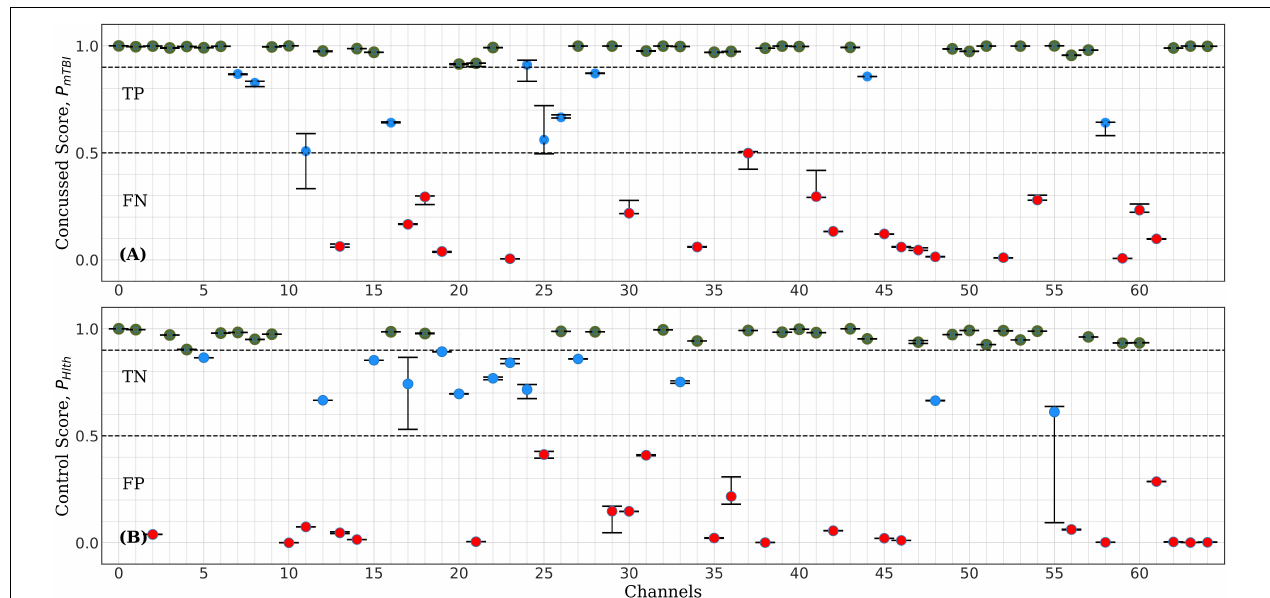
FIGURE 5 | Representative example of ConcNet 2 test output scores (circle markers), P Hlth and P Mtbi , respectively, for one control (bottom) and one concussed (top) participants. The horizontal axis marks the channel number used as input, and the vertical axes correspond to test output scores in the range [0, 1]. The error bars are based on the results of eight data segments per participant, and the circle marker corresponds to the median of these values. Green markers represent channels with medians above 0.9 and 2.5th percentile greater than 0.85. Blue markers correspond to channels with median greater than 0.5 but lower percentiles below 0.85, while red markers correspond to channels with medians less than 0.5 (i.e., misclassifications).